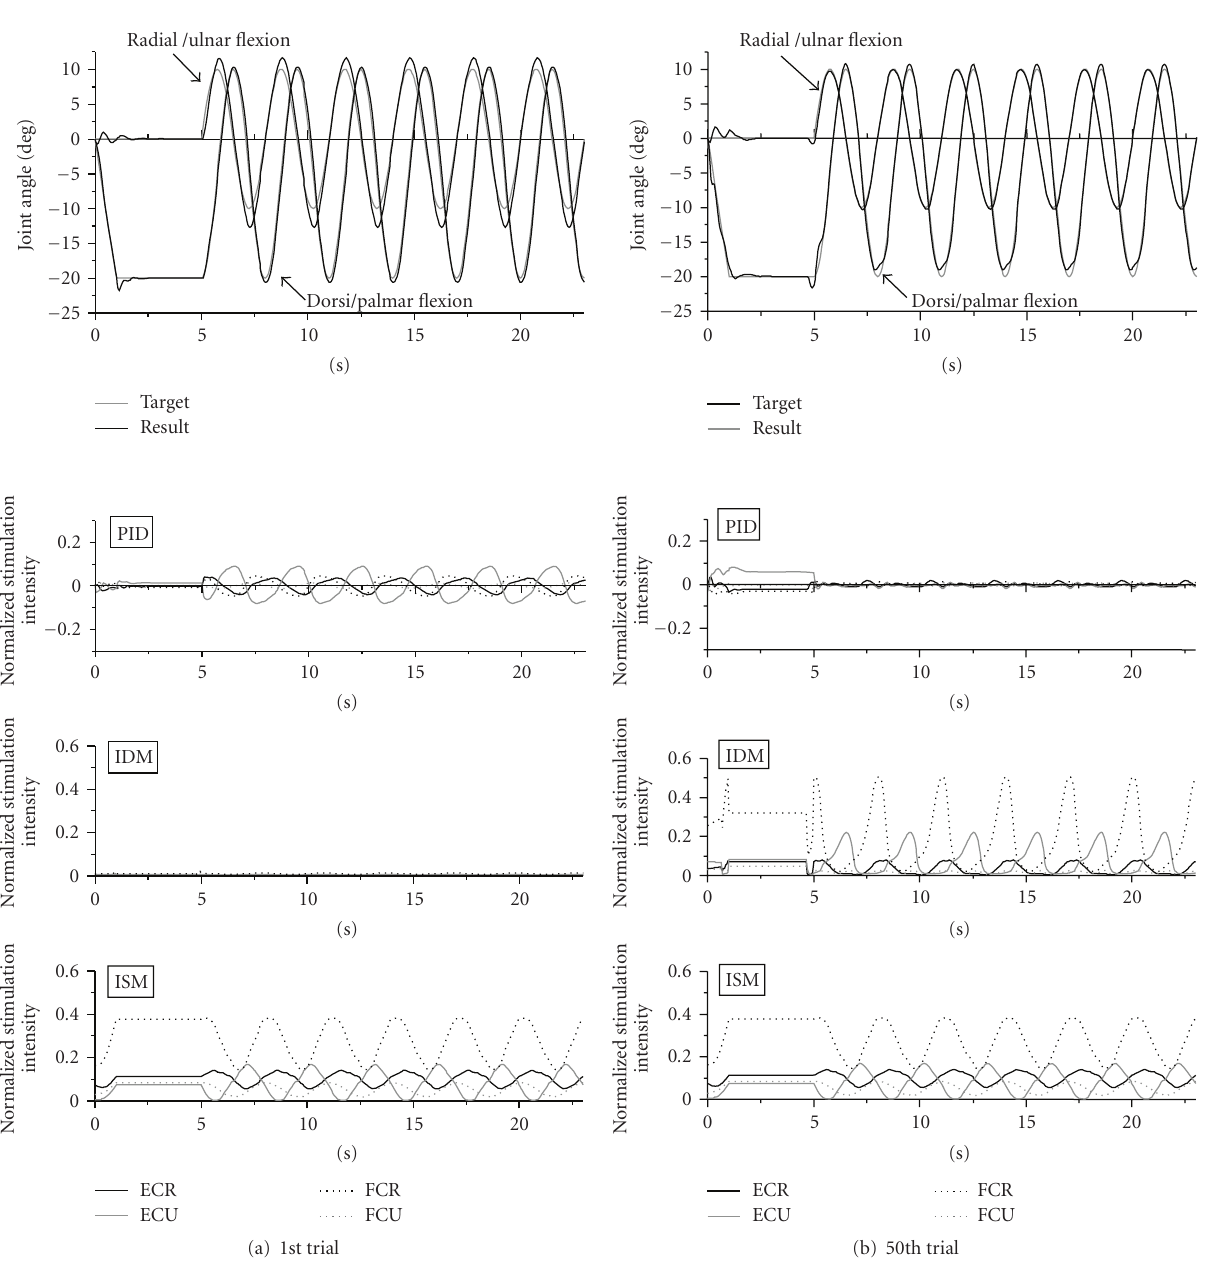
Figure 7: An example of control result by the FEL-FES controller using the ISM and the IDM. (model C, center at palmar position, cycle period of